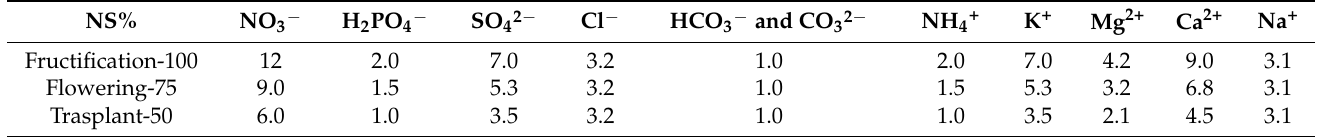
Table 2. Nutritive solution (NS) and percentages used in each of the phenological stages of the cultivation of habanero pepper under greenhouse conditions.